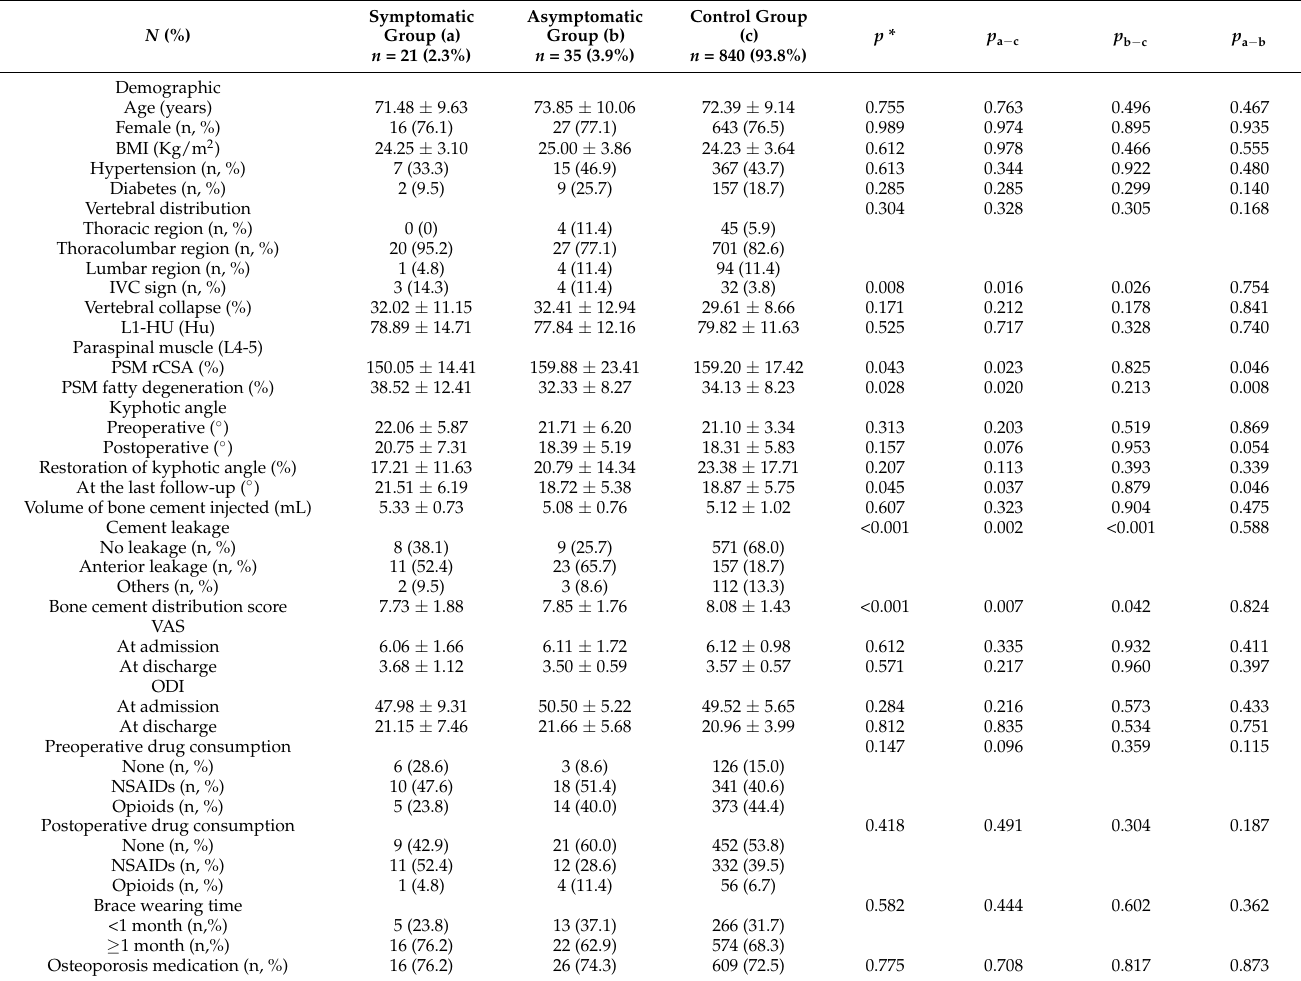
Table 2. Intergroup comparison of patients’